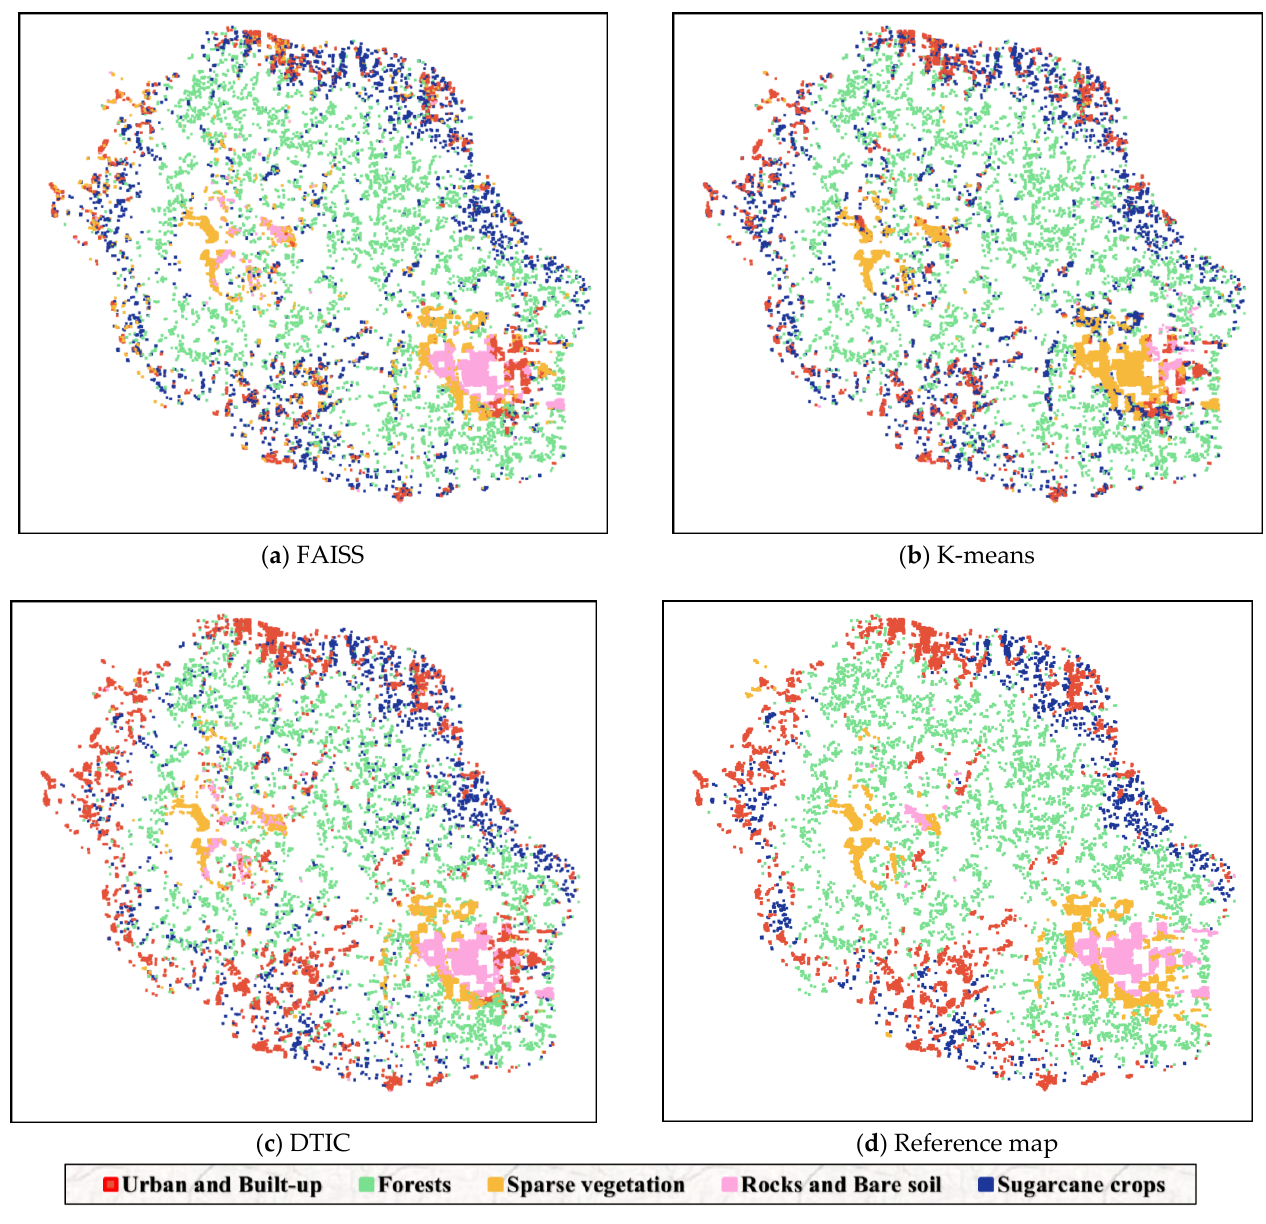
Figure 7. Clustering maps of the Reunion Island Dataset produced using different methods with random initial cluster centers. ( a ) FAISS; ( b ) K-means; ( c ) DTIC; ( d ) reference map.